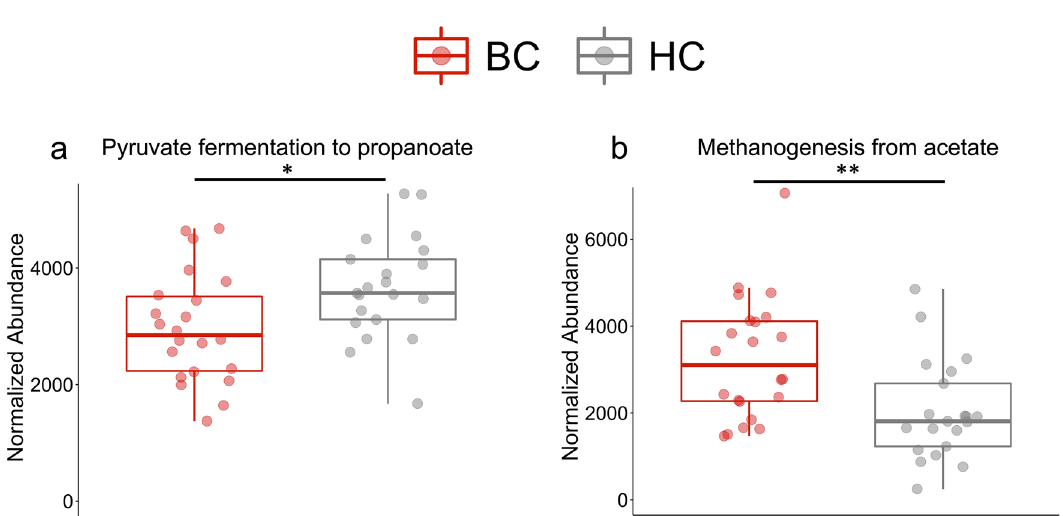
Figure 7. The functional profile of the gut microbiome differs between patients with breast cancer and healthy controls. Based on the Wilcoxon test and the Benjamini–Hochberg procedure, 43 pathways were significantly different between BC and HC. Two pathways were highlighted as they are involved in short chain fatty acid metabolism, ( a ) Pyruvate fermentation to propanoate and ( b ) Methanogenesis from acetate. Significance: * < 0.05 and ** <